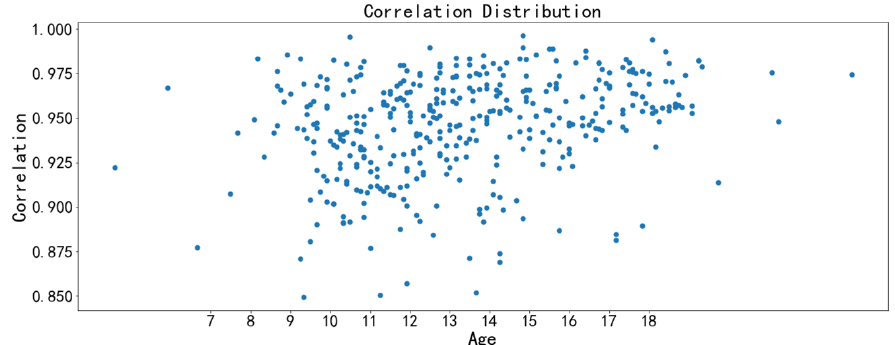
Figure 10. Scatter diagram between correlation with chronological age (males).